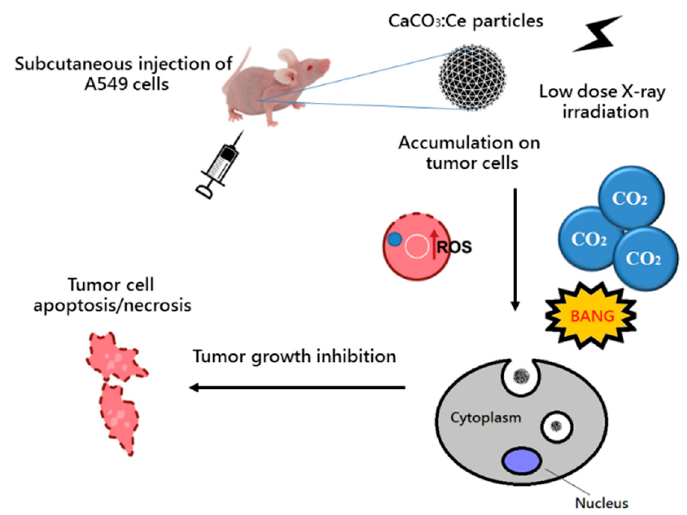
Figure 1. The mechanism of CaCO 3 :Ce activated by X-ray to generate ROS and CO 2 for tumor growth inhibition.